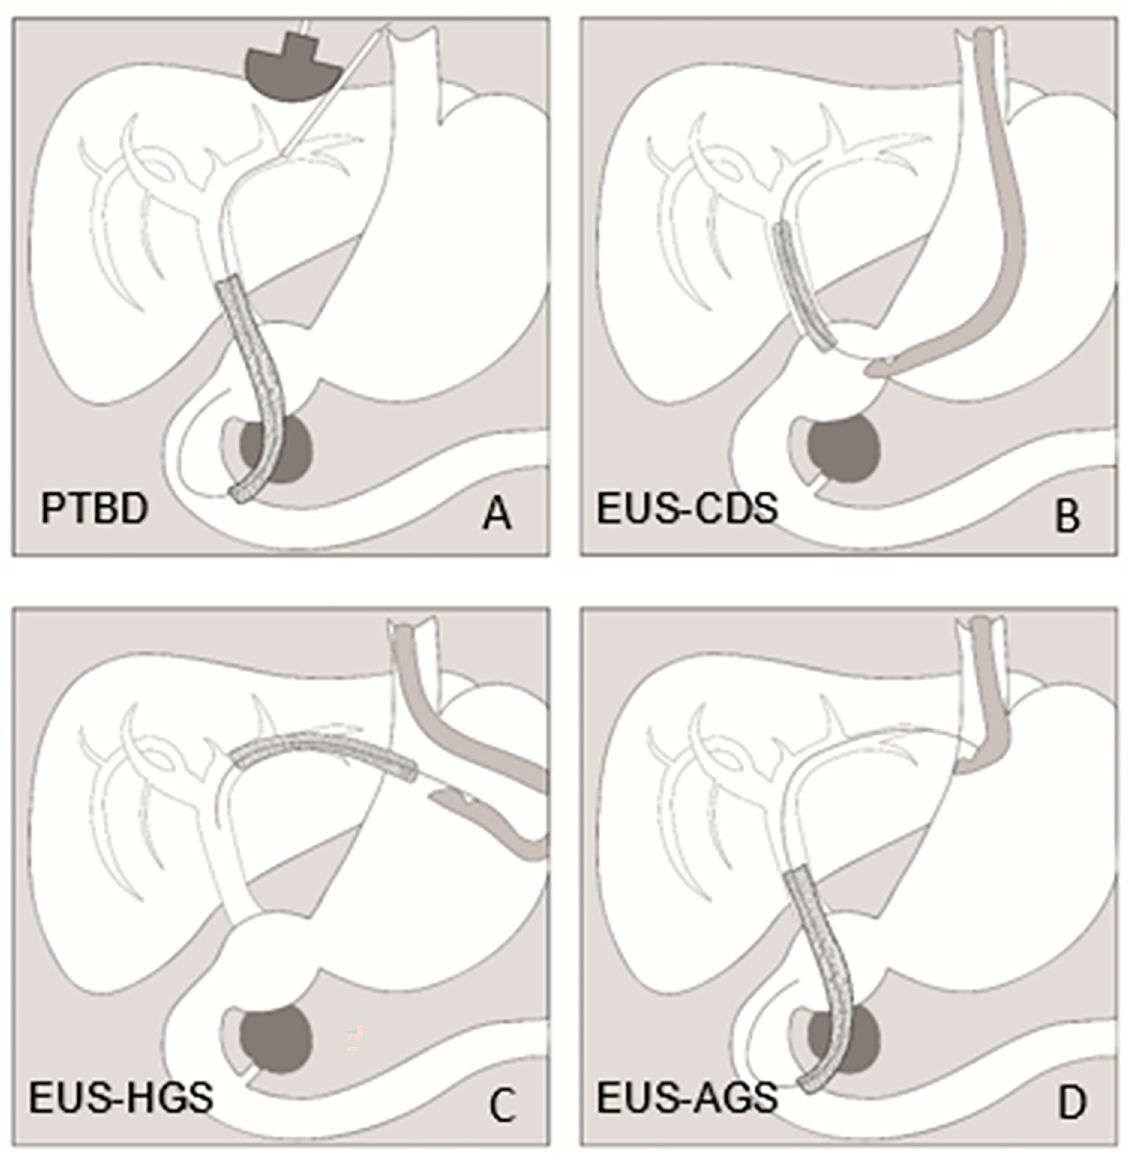
Fig 2. Illustration of the four biliary drainage procedures in the PUMa trial. 1A: PTBD with ultrasound-guided bile duct access, 1B: EUS- guided choledochoduodenostomy (EUS-CDS), 1C: EUS-guided hepaticogastrostomy (EUS-HGS), 1D: EUS-guided antegrade stenting